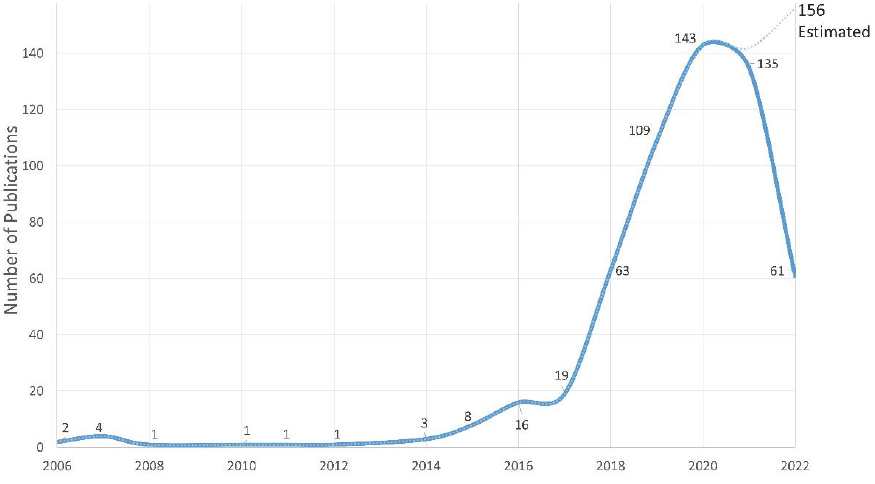
Figure 12. Historical trend of published studies in Industry 4.0 for construction (period 2006 –